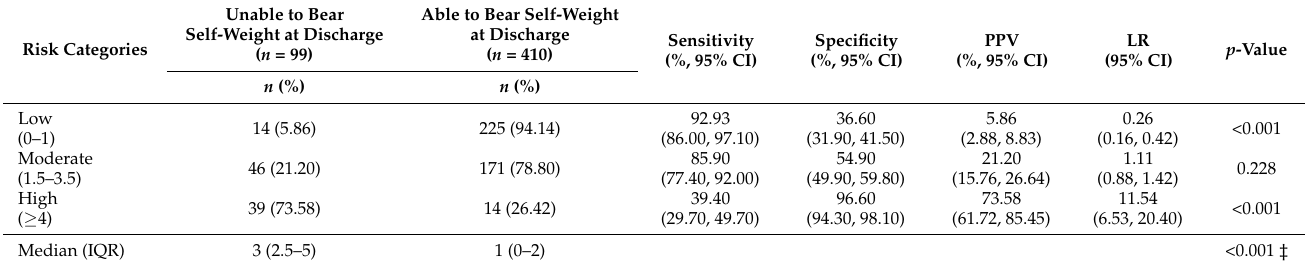
Table 4. Prognostic accuracy of each score risk